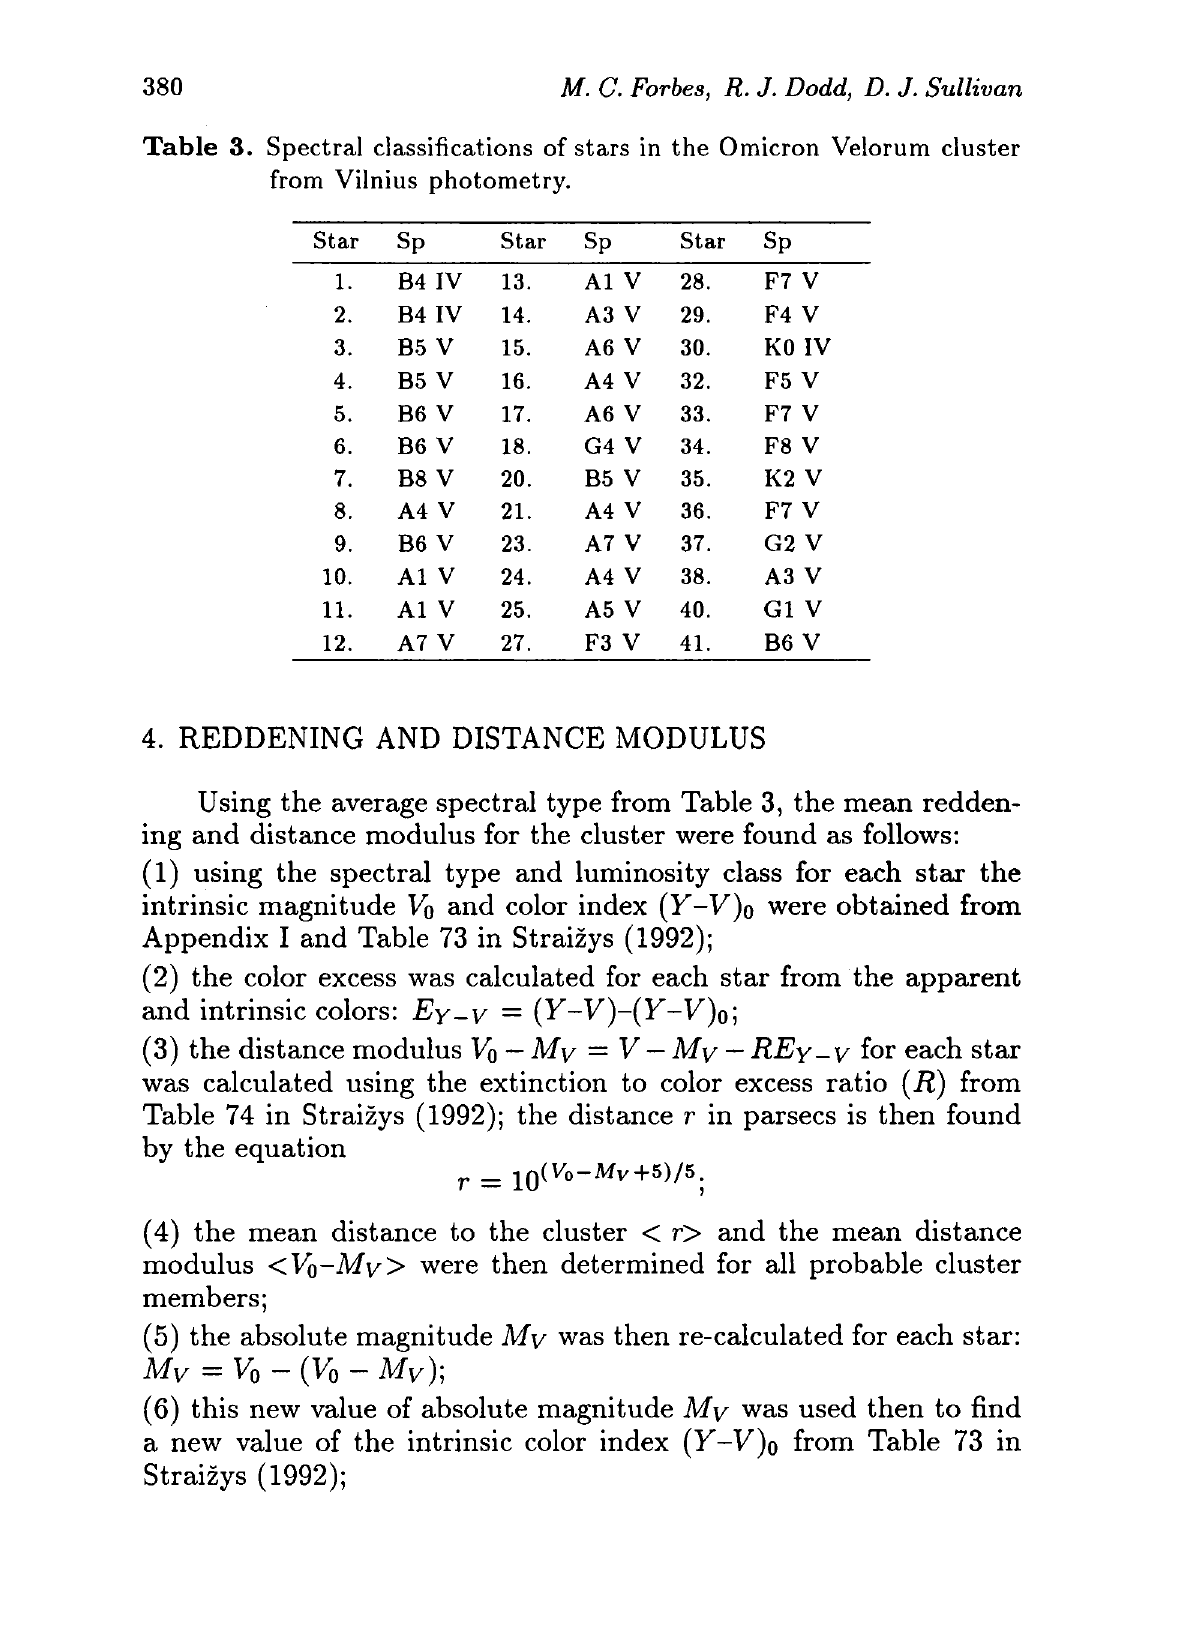
Table 3. Spectral classifications of stars in the Omicron Velorum cluster from Vilnius